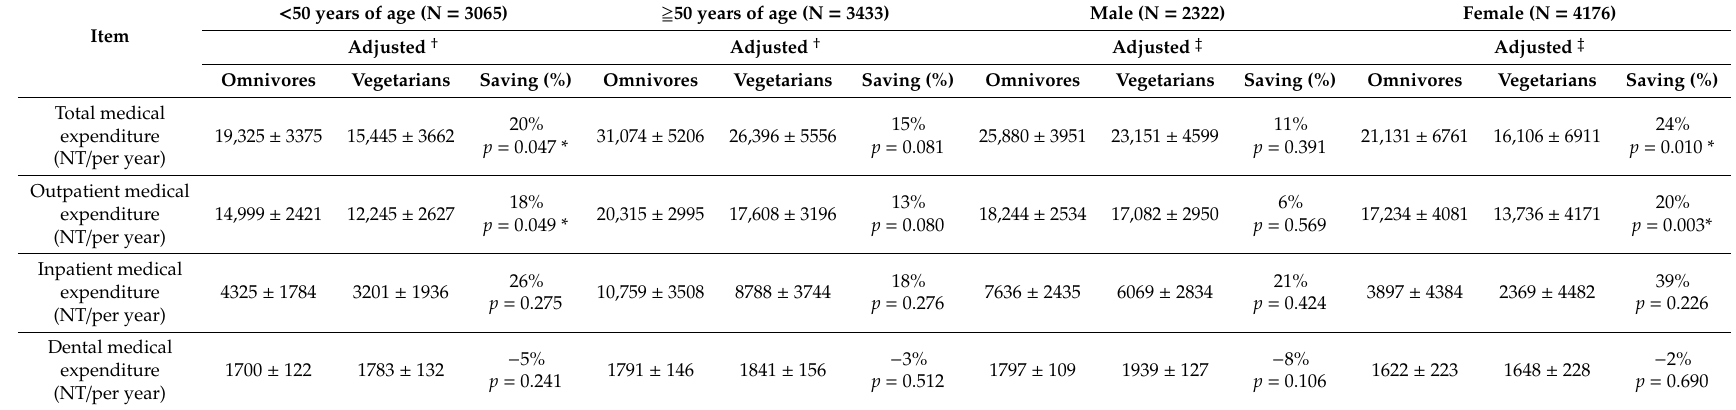
Table 3. Comparison of annual total medical, outpatient, hospitalization, and dental expenditure between non-vegetarians and vegetarians after stratifying by age and sex in New Taiwan Dollars